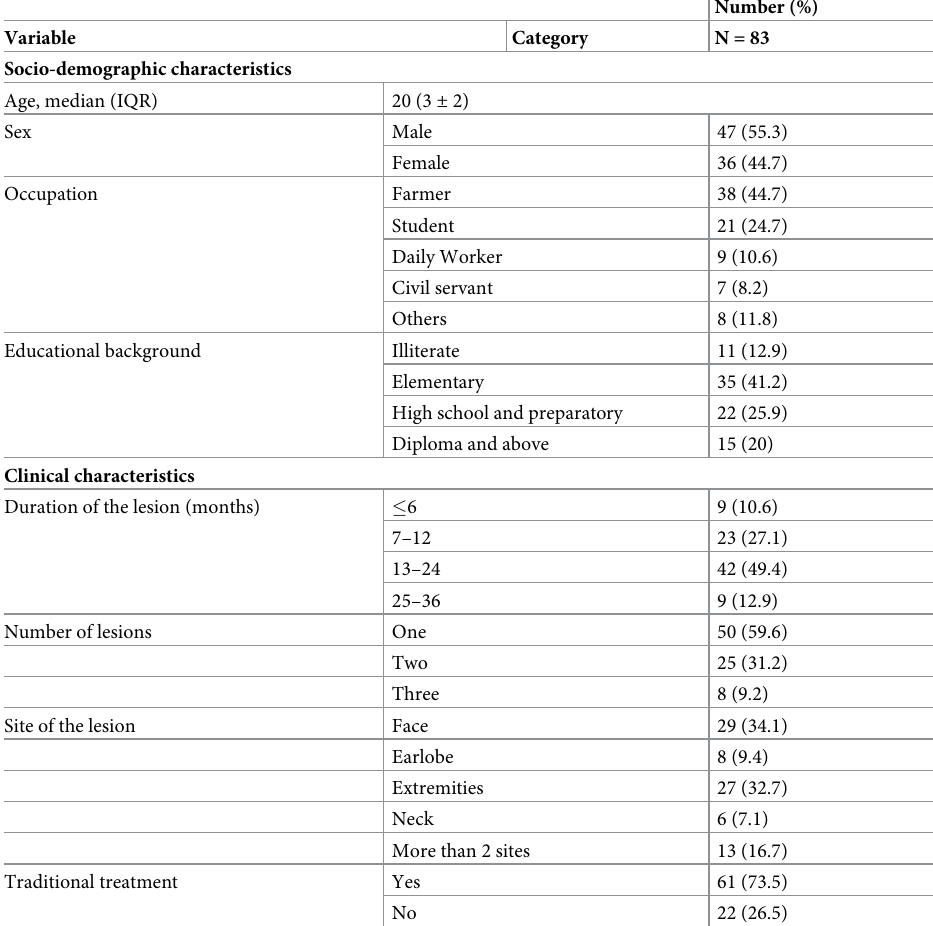
Table 1. Patient characteristics of LCL patients on IL SSG treatment, Boru Meda General Hospital,